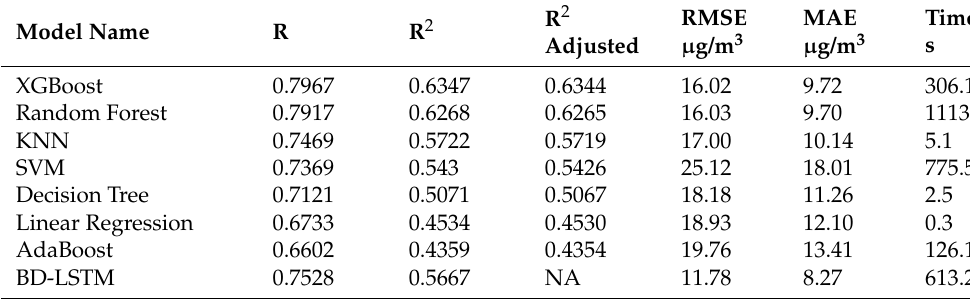
Table 5. Monsoon cross-validation results (June, July, August, September).